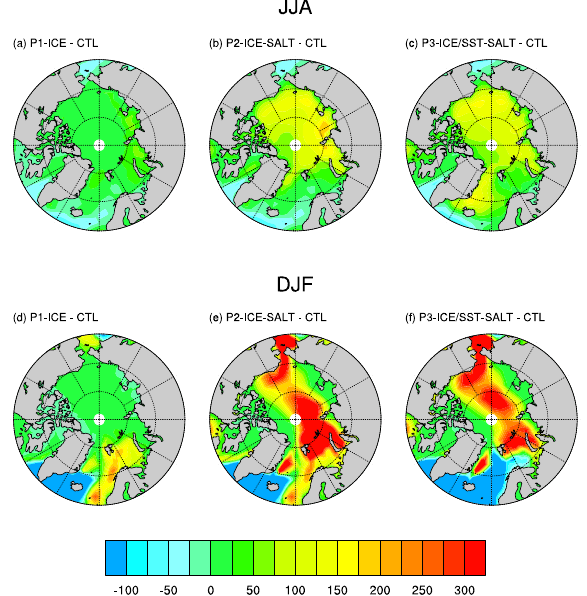
Fig. 8. Average summer (JJA) and winter (DJF) modeled difference (relative to the CTL simulation) in the total sea salt surface emission fluxes (10 6 m − 2 s − 1 ) in response to changes in sea ice extent.